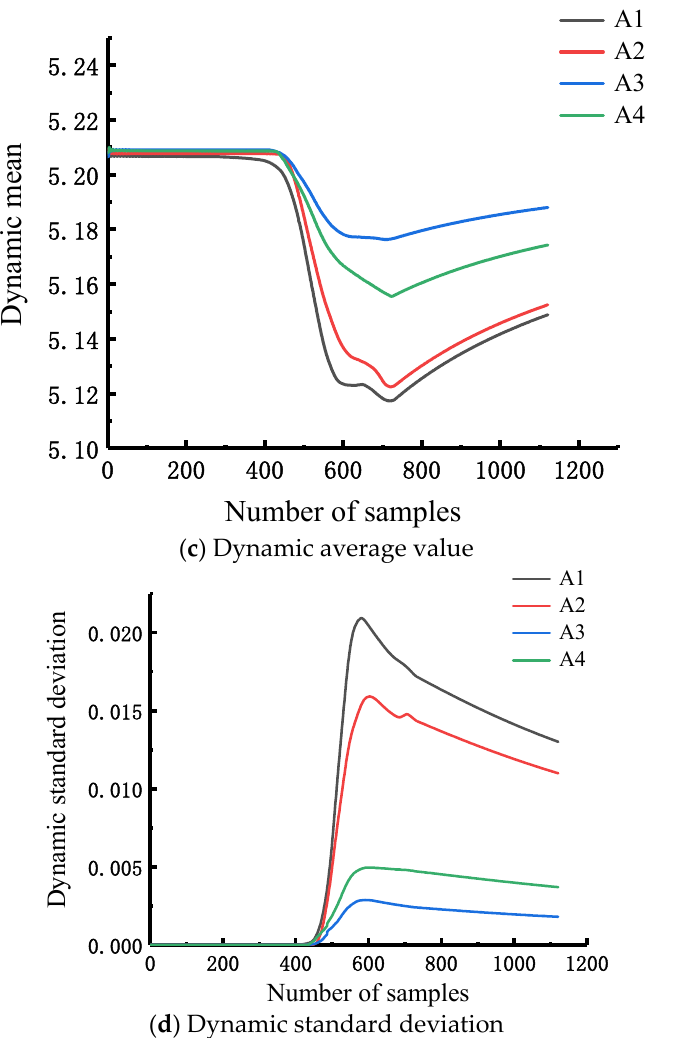
Figure 30. Analysis of pressure sensor dynamic data when rotation generates slippage.